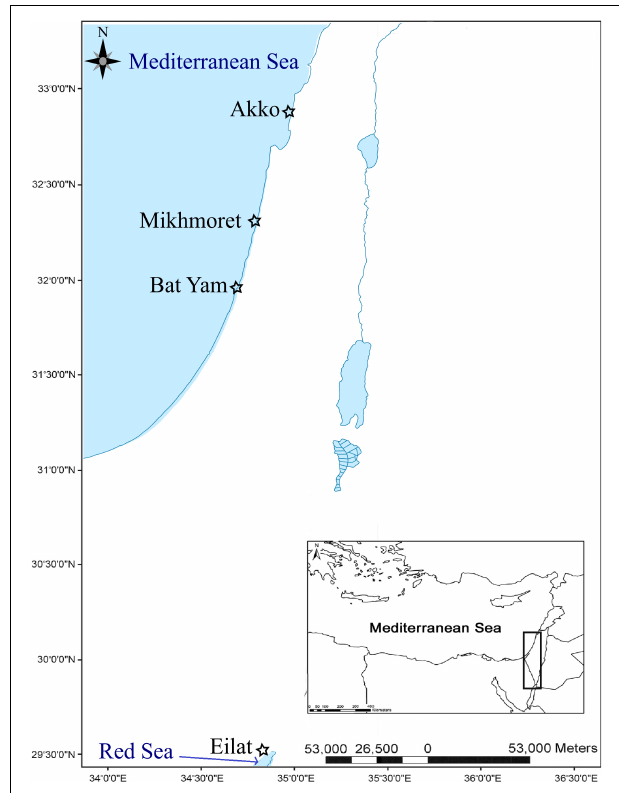
FIGURE 1 | Study area and location of sampling sites along the Mediterranean and Red Sea coasts of Israel (marked with a